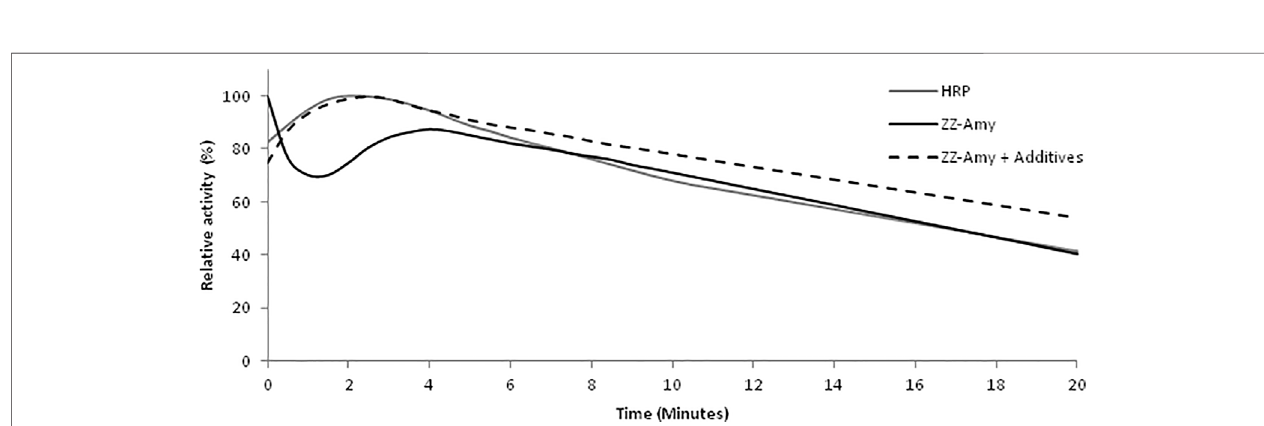
FIGURE 3 | Comparison of the luminescence kinetics of the commercial chemiluminescent HRP/luminol assay and with the bioluminescent fusion protein ZZ- AmyLuc assay. The HRP/luminol chemiluminescent assay was performed by mixing 5 µl of HRP-conjugated secondary antibody with 50 µl of Solution 1 and 50 µl of Solution 2. The standard bioluminescent assay with ZZ-AmyLuc was performed by mixing 5 µl of fusion protein with 95 µl of a solution consisting of 0.5 mM D-luciferin, 2 mM ATP and 4 mM MgSO4 in 0.1 M Tris-HCl pH 8,0. The assay with additives was performed in the additional presence of 0.25 mM CoA and 5 mM DTT.